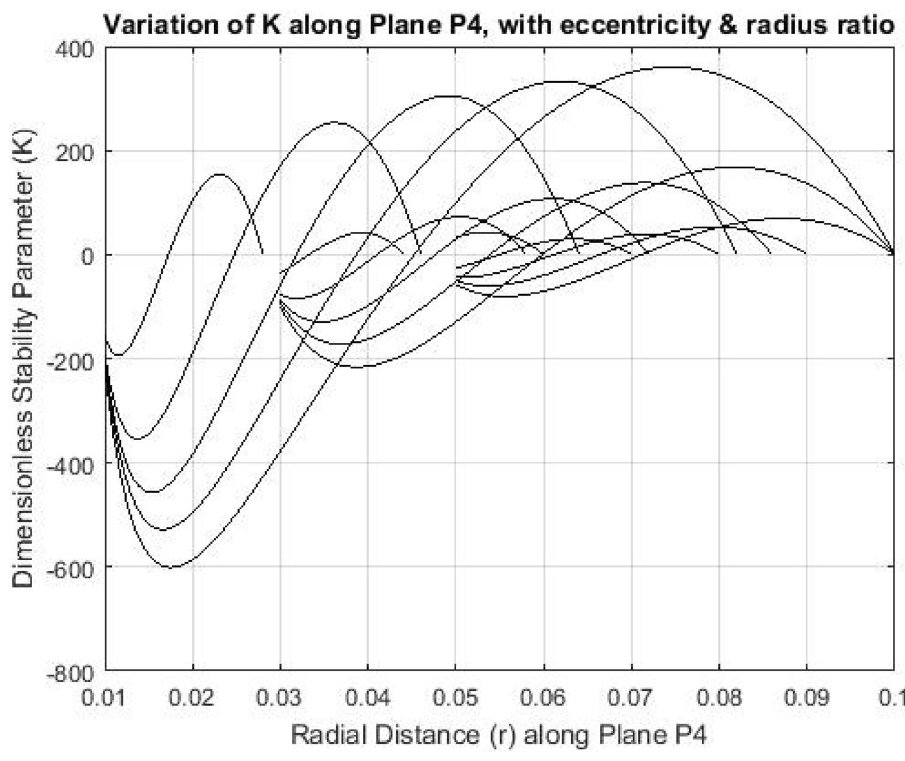
Fig. 5 Effect on K with varia- tion in r , k and ɛ along plane P